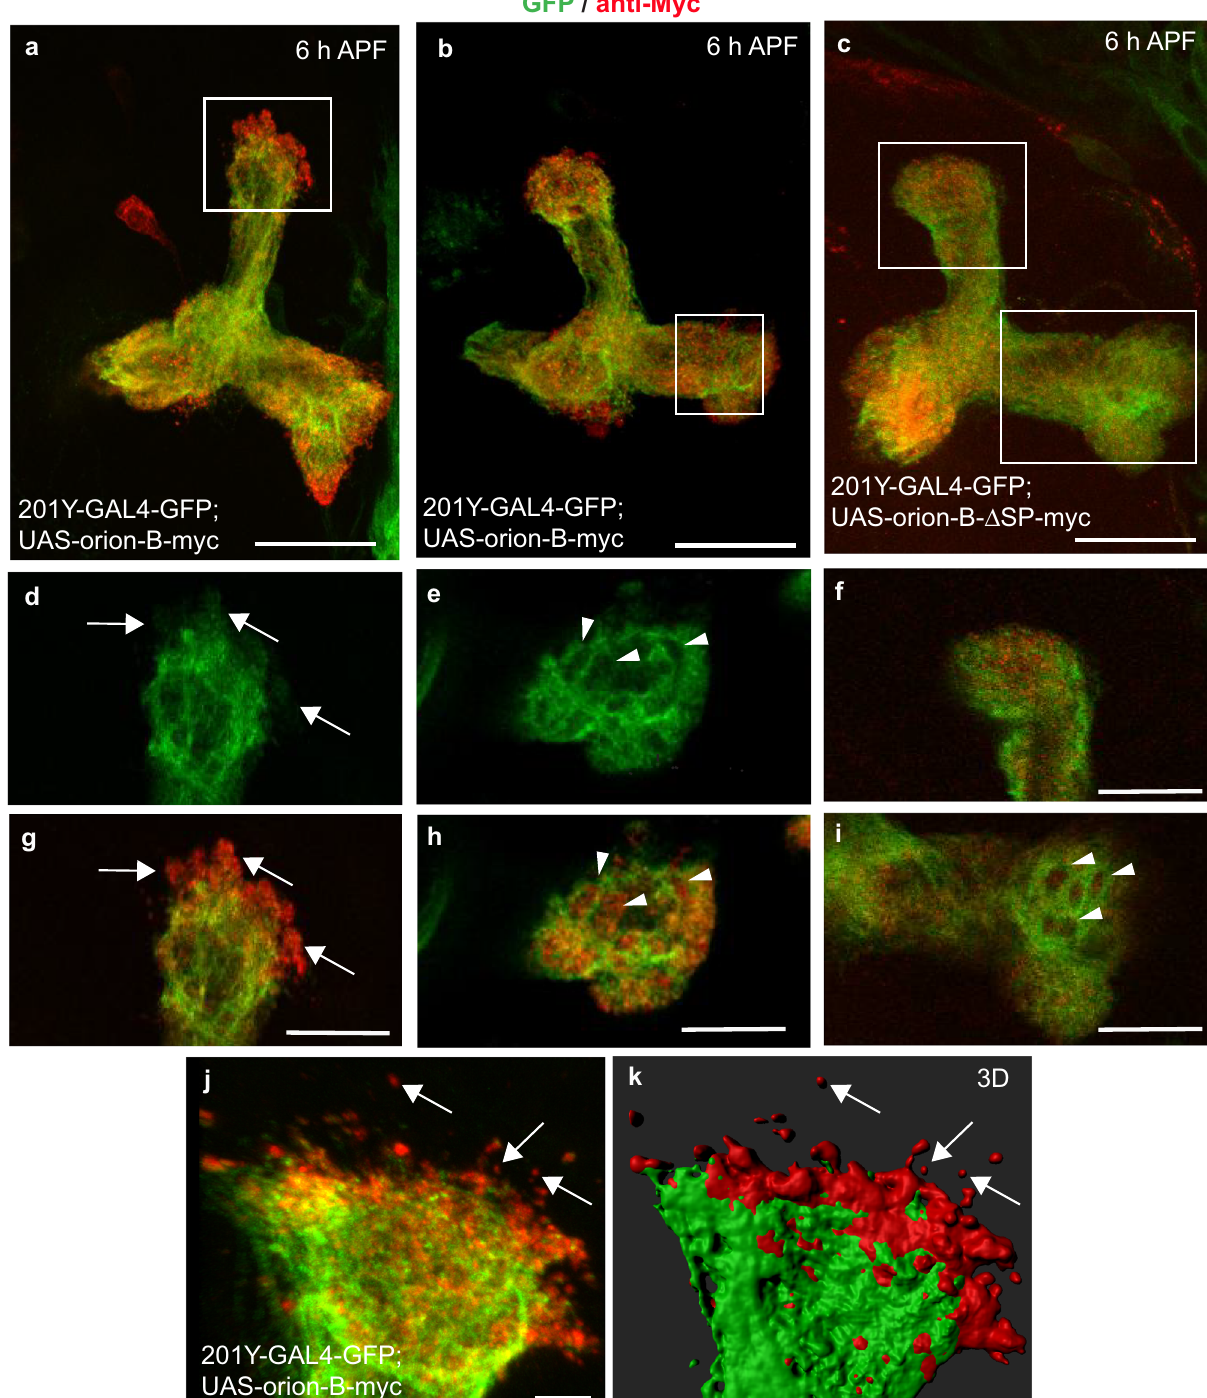
Fig. 3 Orion is extracellularly present on MB γ axons. a – k Six-hour APF γ axons are visualized by the expression of 201Y-GAL4 -driven UAS-mCD8-GFP (green). a , b , j , k γ axons expressing the wild-type Orion-B-Myc protein (red) ( n = 10 MBs). c γ axons expressing the Orion-B-Myc protein lacking the signal peptide ( Δ SP) ( n = 9 MBs). a – c are confocal Z-projections and j is a unique confocal plane. d , g Higher magni fi cation images of the region indicated by a rectangle shows a representative unique confocal plane. Note the presence of Myc-labeled Orion-B outside the γ axon bundle (arrows). e , h Higher magni fi cation images of the region indicated by a rectangle in b showing a representative unique confocal plane. Note the presence of Myc-labeled Orion-B inside the hole-like structures present in the γ axon bundle (arrowheads). f , i Higher magni fi cation images of the vertical and medial γ lobes, respectively (rectangles in c ). Orion-B- Δ SP-Myc is observed neither outside the γ axons ( f ) nor in the hole-like structures (arrowheads in i ). j , k Presence of Myc-labeled Orion-B extracellular proteins not associated with GFP-labeled axon membranes can be observed outside the γ axon bundle (arrows). k Three-dimensional surface-rendering (3D) of the confocal image. j Reveals close apposition of GFP-labeled axons and Myc-labeled Orion and reveals Orion is present as small extracellular globules. Scale bars represent 40 µ m in a – c , 20 µ m in d – i and 5 µ m in j , k . Full genotypes are listed in the Supplementary list of fl y